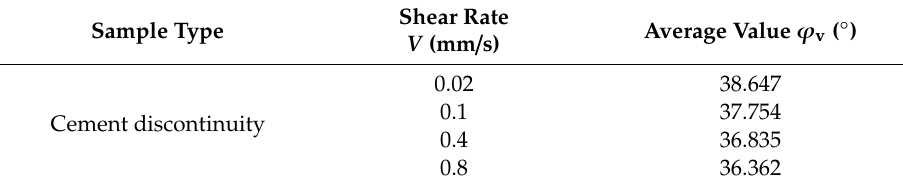
Table A5. Average values of rate-dependent friction angle ϕ v for di ff erent cement discontinuity samples with the shear rate varying from 0.02 mm / s to 1 mm / s.